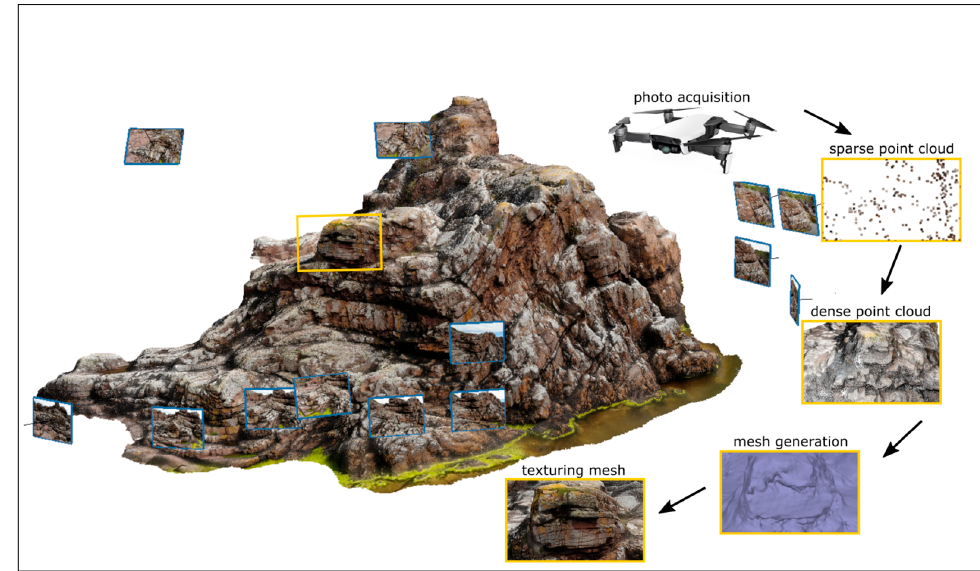
Figure 3. Photogrammetry workflow from photographs acquisition to generating texture meshes. Manual photograph acquisition was used for the southern outcrop (The Haven), while for the northern outcrop (Muiri Geo), both manual flight paths and automated flight paths were used. The automated acquisition flight paths were flown as a double grid (two orthogonal flight grids). For the automated data acquisition, Pix4Dcapture was used with a front overlap of 80%, a side overlap of 70% and a 70° camera angle. When flying the manual flight paths, similar or better photograph overlaps as with the automated acqui- sition are desired. All areas of the presented 3D outcrops have a final image overlap of more than nine images.